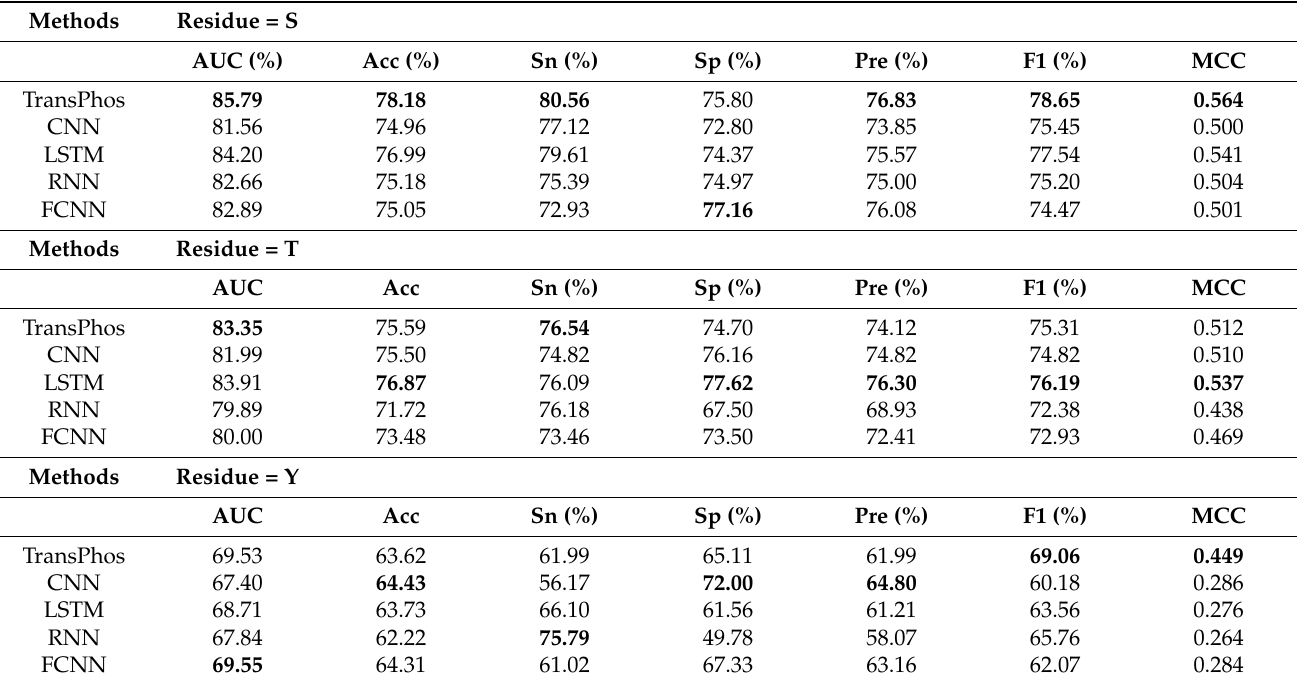
Table 1. Performance comparison of various deep learning models on the training dataset P.ELM, ten-fold cross validation was